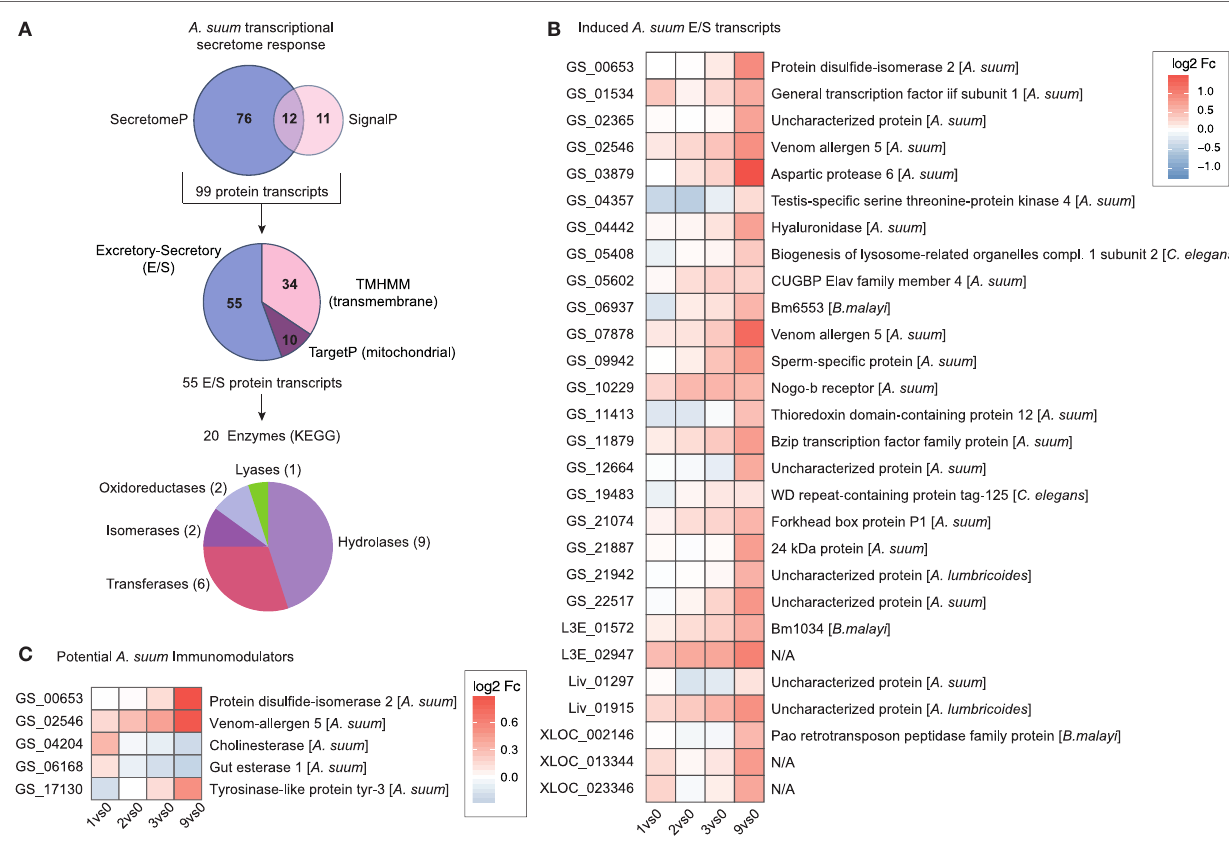
FigUre 6 | The secretome response of Ascaris suum . (a) The pipeline to identify A. suum excretory-secretory (ES) transcripts used SignalP and SecretomeP to annotate classical ( n = 23) and non-classical ( n = 88) ES genes and excluded mitochondrial ( n = 10; TargetP) and transmembrane ( n = 34; TMHMM) protein transcripts. KEGG ENZYME identified enzyme classes of ES transcripts are depicted in the bottom pie chart. (B) Time-resolved expression of n = 28 induced A. suum ES transcripts. (c) Differentially expressed A. suum transcripts that matched to genome prediction of A. suum immunomodulatory ES products based on homology to other nematodes